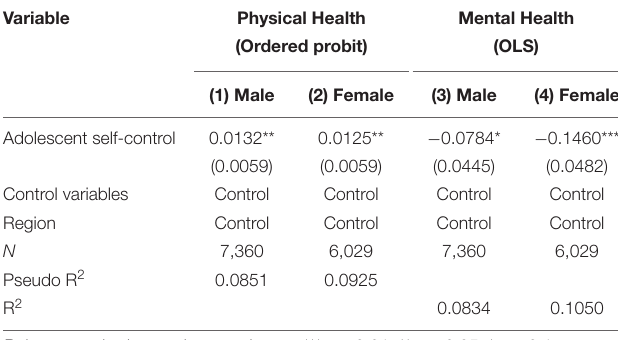
TABLE 4 | Effects of adolescent self-control on physical and mental health in adulthood in different gender sub-groups.